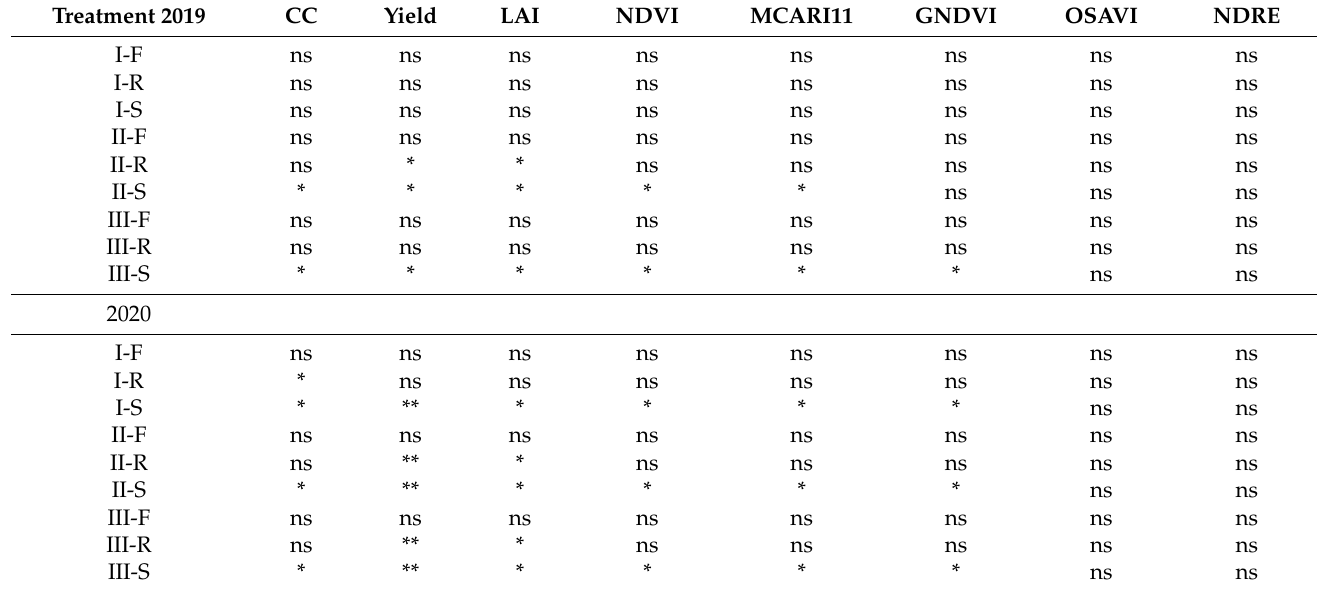
Table 6. Partial ANOVA table of variables by sowing period and irrigation treatment (2019 and 2020).